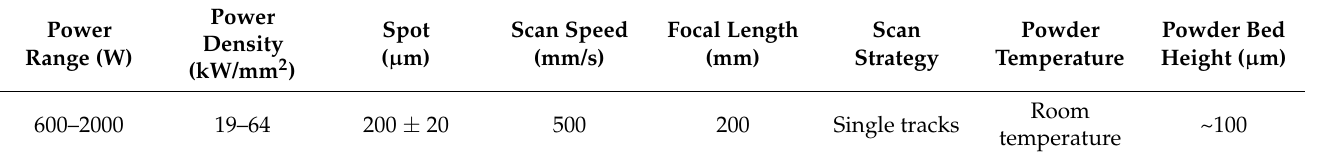
Table 1. Laser main